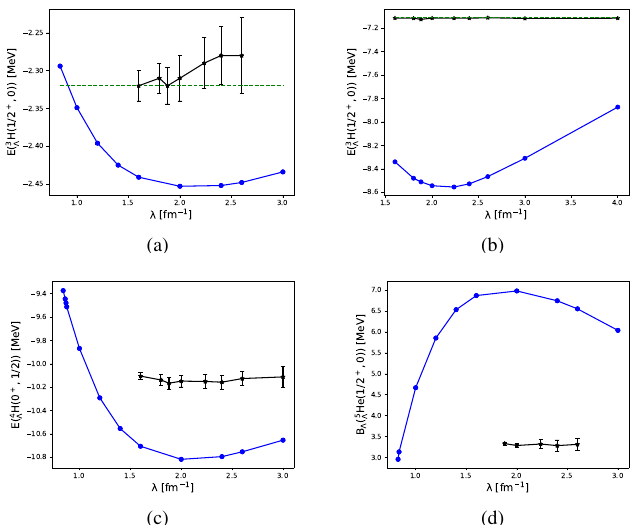
Figure 1. Dependence of the binding (separation) energies in A = 3 − 5 hypernuclei on λ flow pa- rameter. The results (blue circles, panels (a, c,d)) are computed using the SMS N 4 LO + 450 [10] NN potential SRG-evolved to λ NN = 1 . 6 fm -1 and the NLO13(500) YN interaction (with CSB included) evolved to a wide range of flow parameter. In panel (b) the strength of the original NLO13 potential is amplified by a factor of 1.5 so that 3 Λ H is more tightly bound. Black triangles are obtained with inclusion of SRG-induced YNN (panels (a-b)) and of the 3N forces [11] (panels (c-d)). Dashed green lines are binding energies computed by solving the Faddeev equation for the bare NN and YN interactions. 4 Λ H